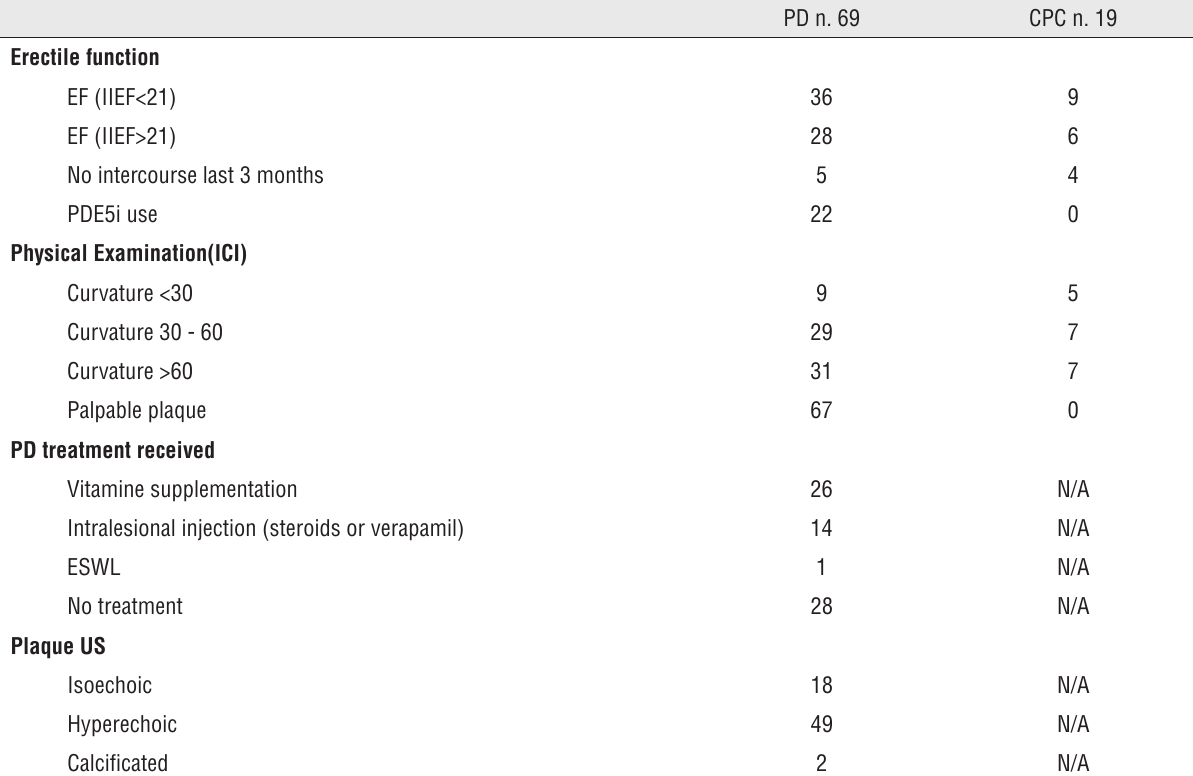
Table 1 - characteristics of